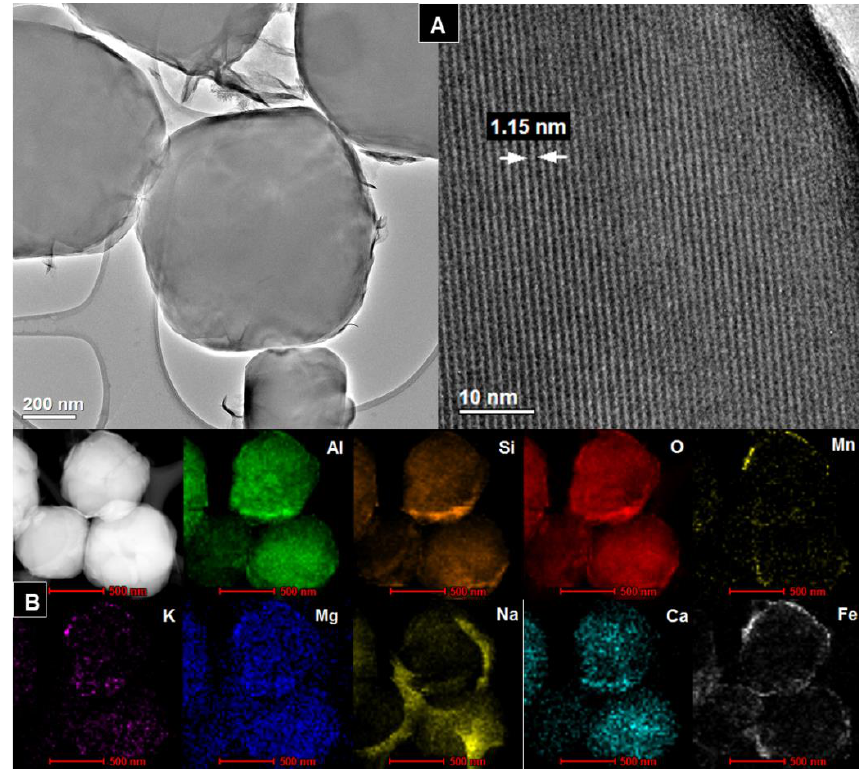
Figure 7. ( A ) HR/TEM images and ( B ) STEM-EDS analysis of Na-A-TS sample.